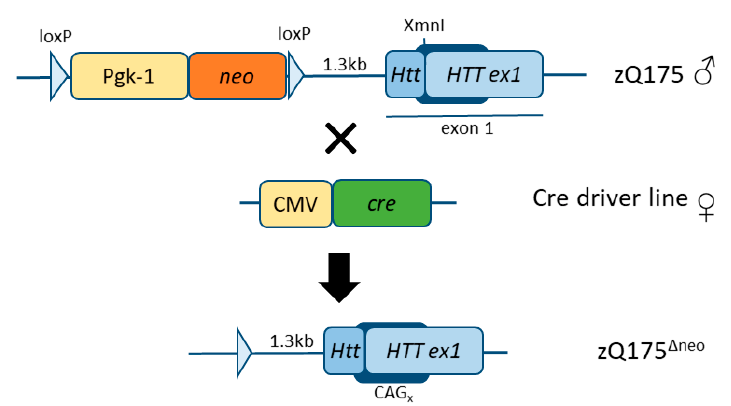
Figure 1. Schematic representation of the generation of the zQ175 ∆ neo mouse line (C57BL/6J back- ground). The floxed neomycin ( neo ) resistance cassette including its promoter (Pgk-1) were